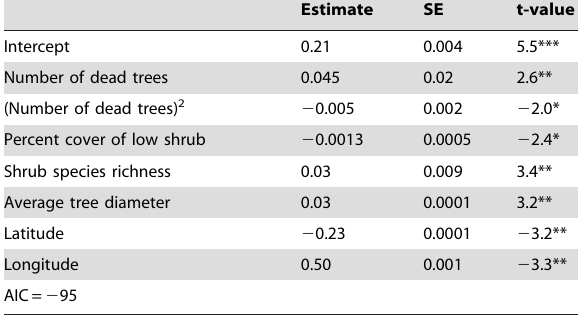
Number of dead trees (standing and fallen) in a radius of 20 m.